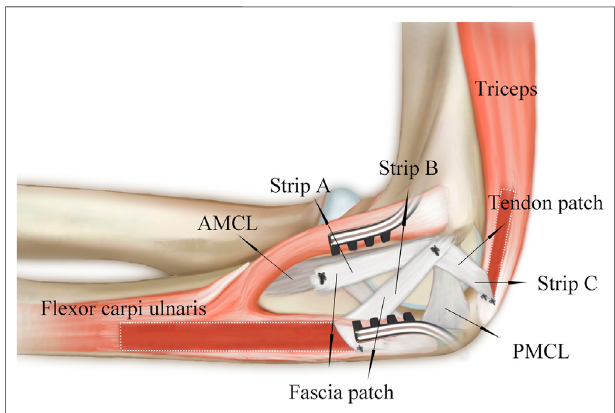
FIGURE 4 | Schematic diagram shows position of reconstructed ligaments in relation to original